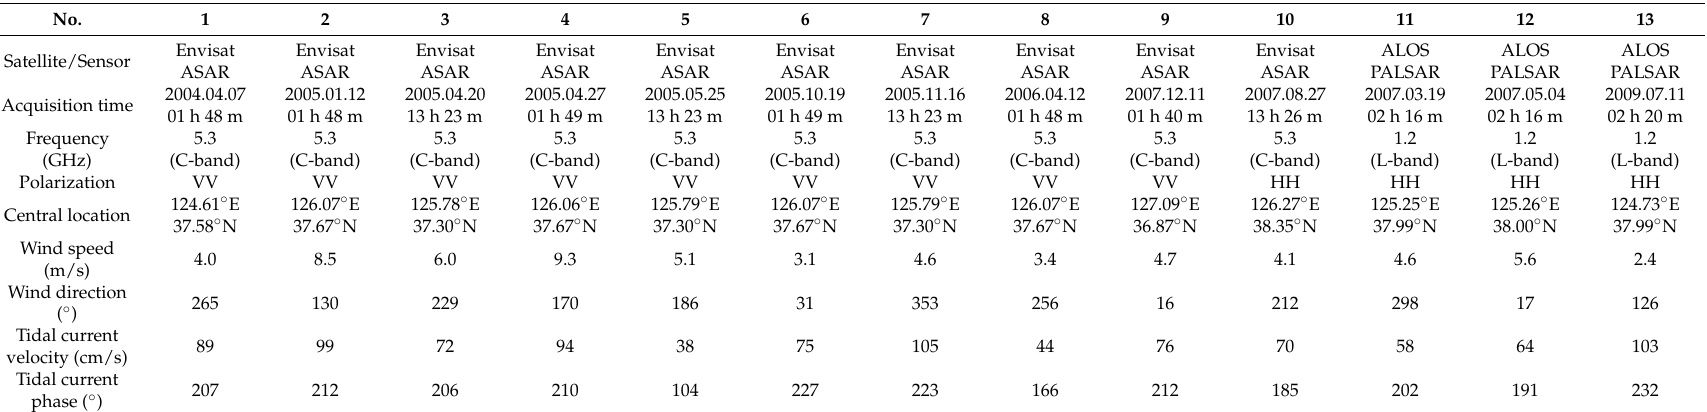
Table 1. Characteristics of the SAR images utilized in the study and environmental conditions at the imaging time. Directions are measured in degrees clockwise from due